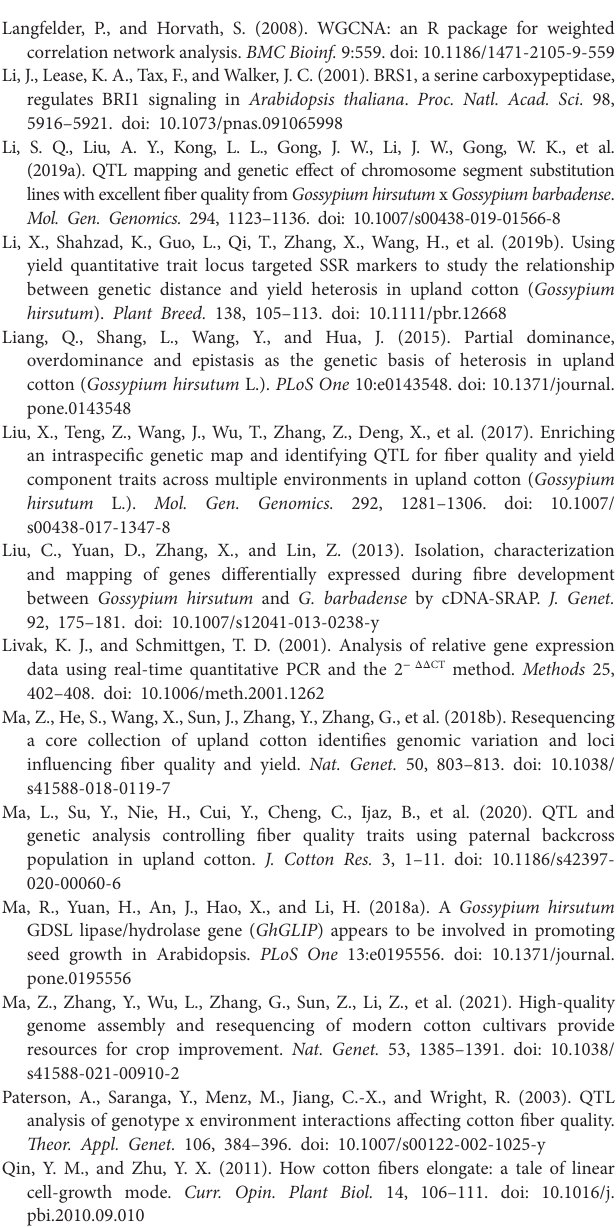
Supplementary Table S15 | Modules associated with specific stages of fiber development.